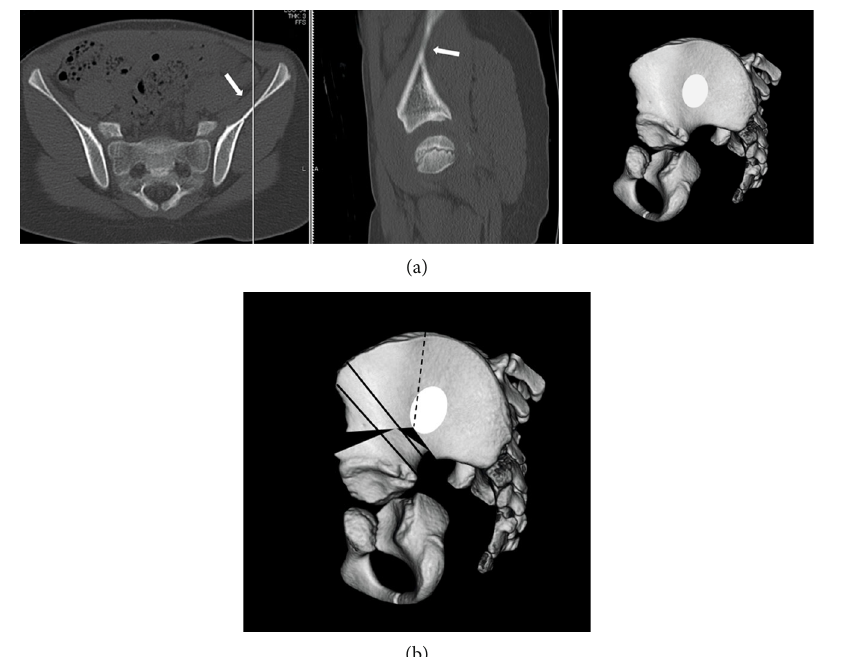
Figure 5: (a) Preoperative CT image of the pelvis of the patient. The white arrows and white ovoid area indicate the thin iliac portion (iliac fossa). (b) The schema of the pelvis of the current case after Salter innominate osteotomy. The black dot line indicates the fracture line, and black lines show the Kirschner